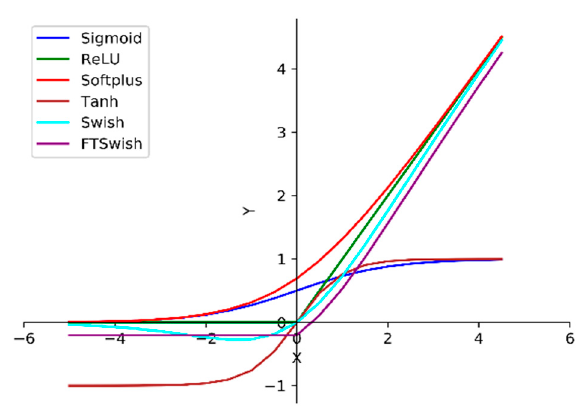
Figure 4. Common baseline activation functions. Best viewed in color.